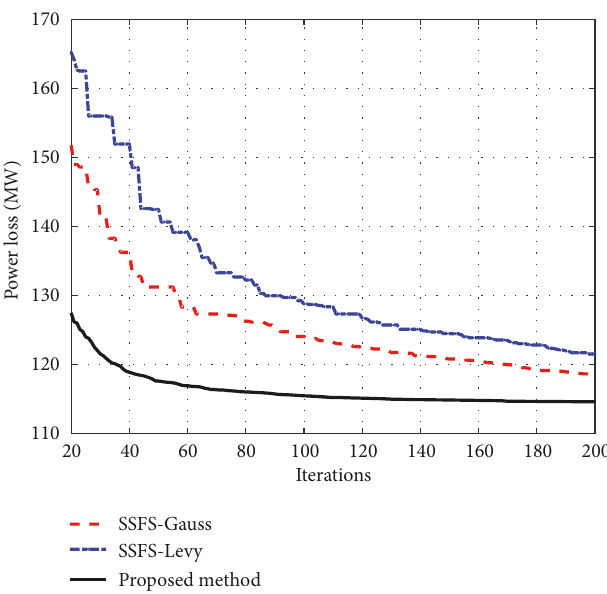
Figure 13: The best run obtained by three methods for power loss optimization of IEEE 118-bus system.